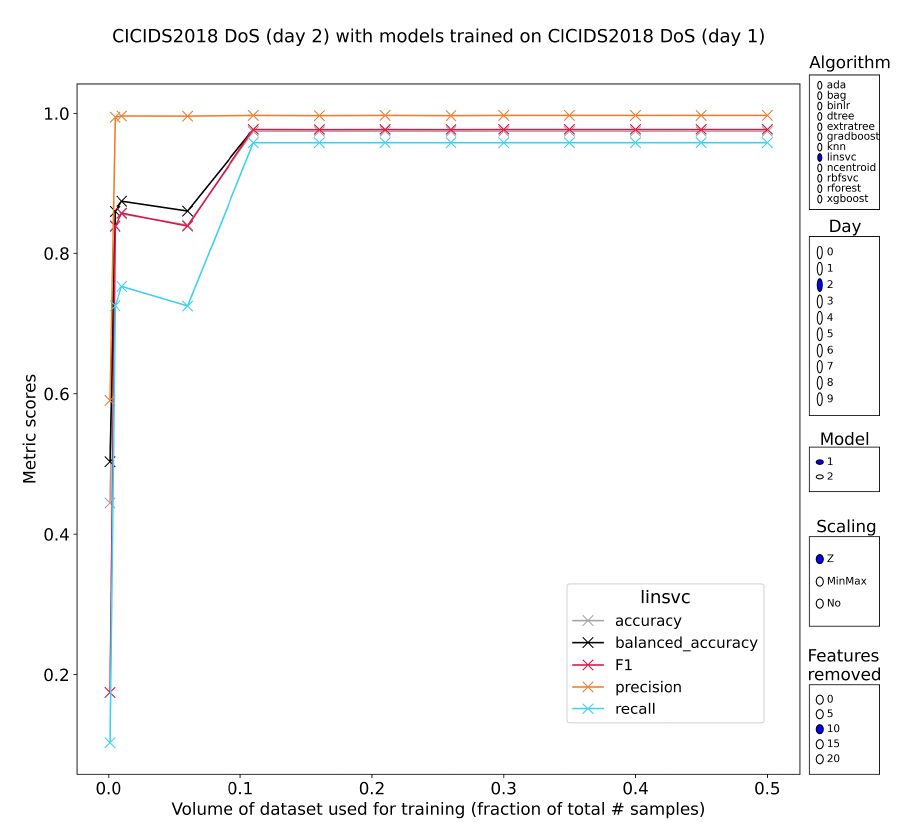
Figure 2. Performance profile of the set of linear SVMs, trained on the first subset of DoS traffic in CSE-CIC-IDS2018, when evaluating the second DoS subset from the same